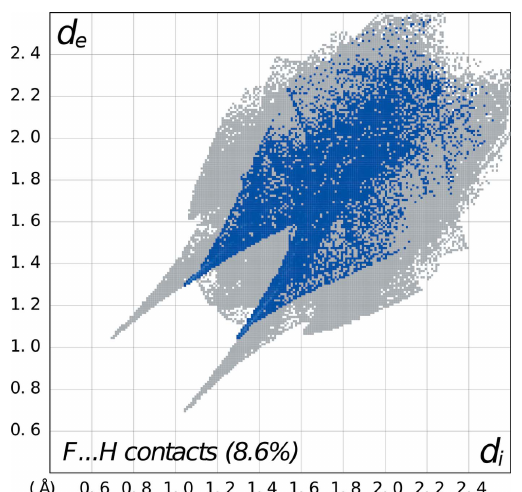
Figure 5 Fingerprint plot for 1 delineated into O (cid:2)(cid:2)(cid:2) H/H (cid:2)(cid:2)(cid:2) O contacts showing the prominent spikes indicating N—H (cid:2)(cid:2)(cid:2) O hydrogen bonds.